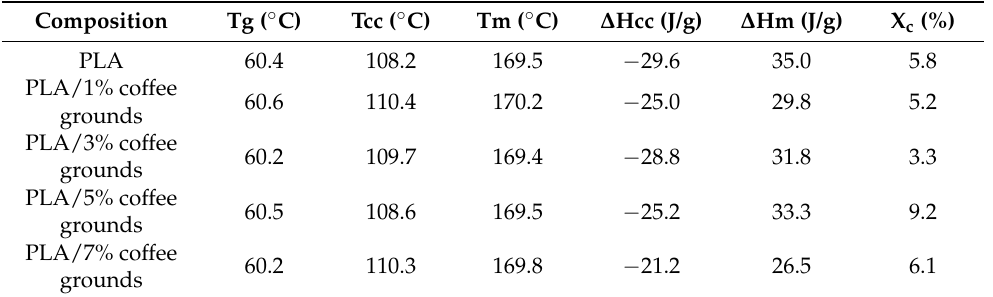
Figure 8. The DSC curves of different PLA/coffee grounds 3D printing products: ( A ) the cooling process of PLA/coffee grounds 3D printing products with different coffee grounds additions; ( B ) the second heating process of PLA/coffee grounds 3D printing products with different coffee grounds additions. Table 1. Characteristics of DSC curves for PLA/coffee grounds 3D printing products with different coffee grounds additions.